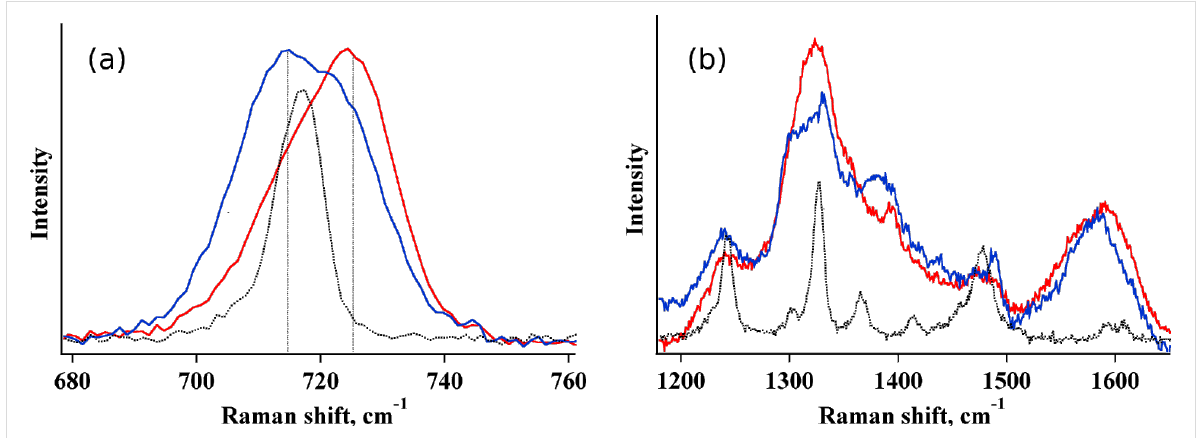
Figure 7: SERS spectra of Adenine (9 × 10 − 4 M) adsorbed on GO/AgNCs obtained with procedure A (red curve) and with procedure B (blue curve). The Raman spectrum (×10) of adenine powder is also reported (black curve).